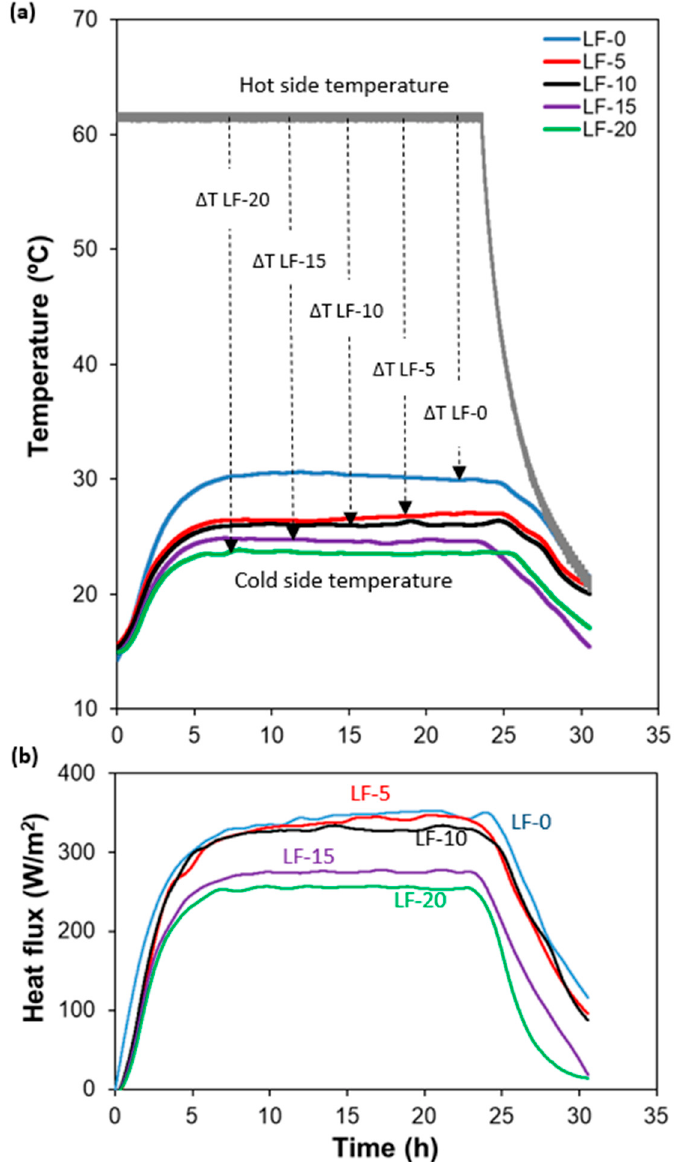
Figure 4. Cold side and hot side temperatures ( a ) and heat flux ( b ) vs. time for samples of lime mortar with a different content of iron (III) oxide.